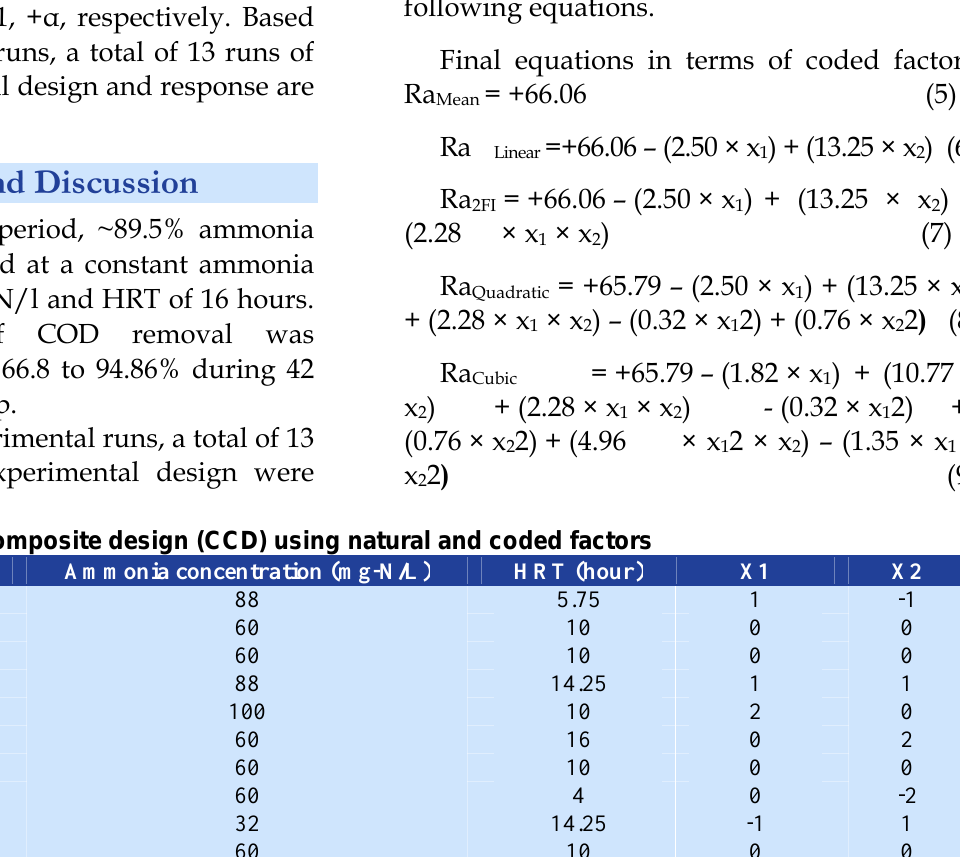
represented by the